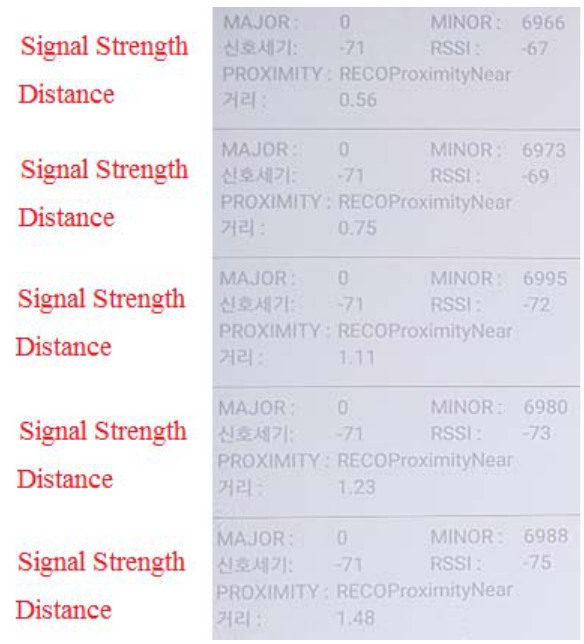
Figure 22. Taking Inventory of the Smart Factory Using Smart PAD.